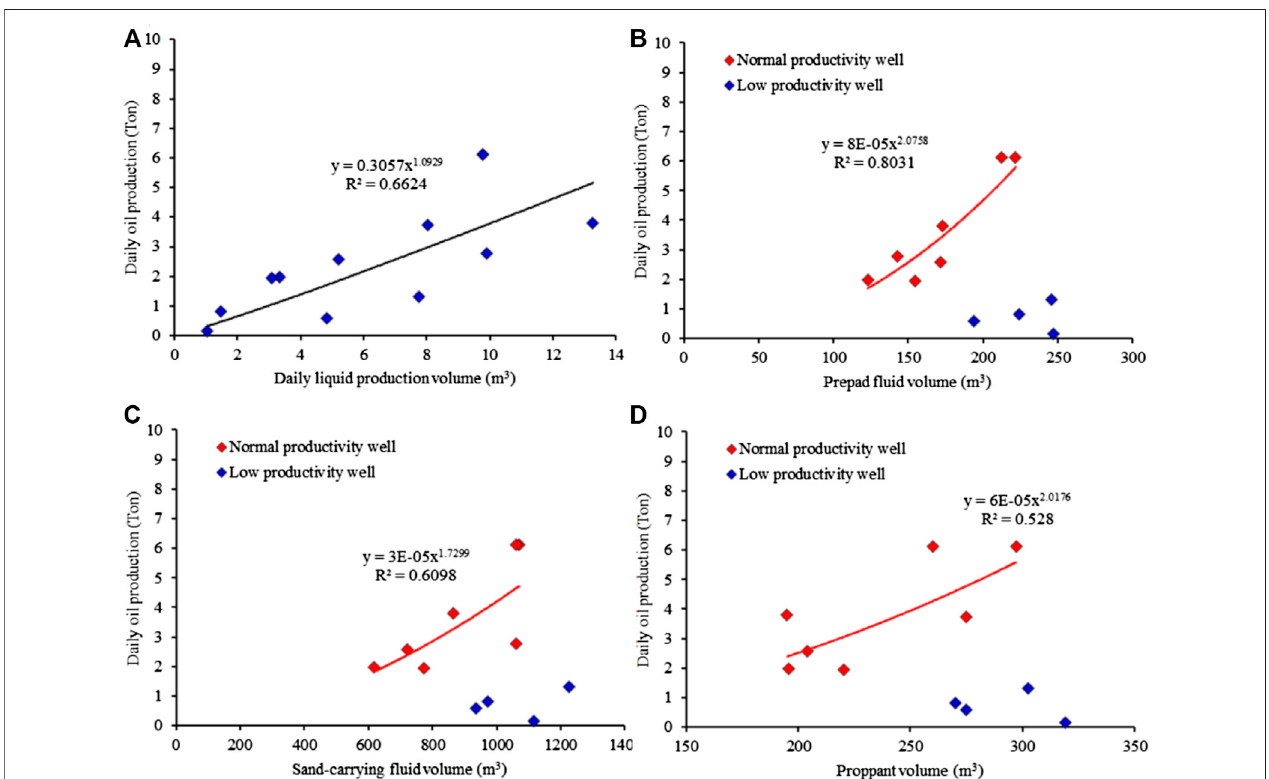
FIGURE 5 | Relationship between fracturing parameters and